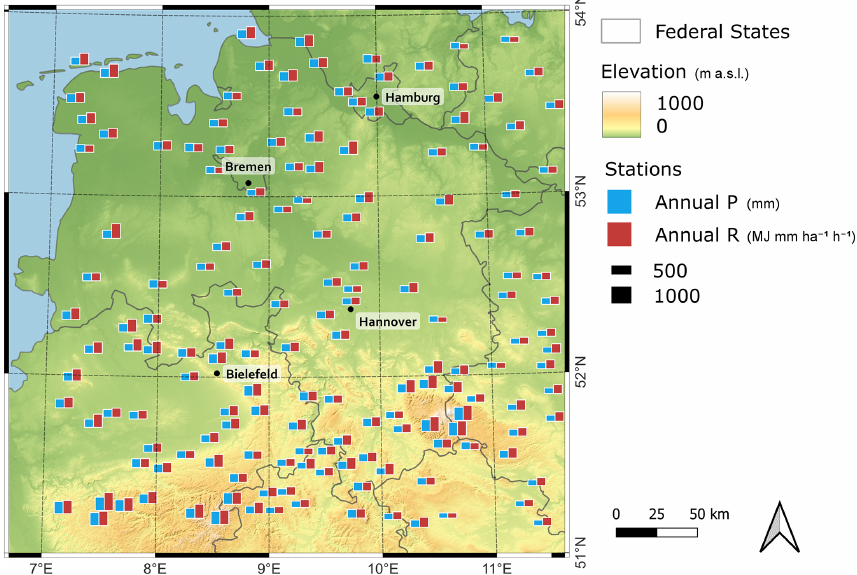
Figure 1. Location of all recording stations ( N = 159). The bar plots indicate the observed annual precipitation volume (blue) and erosivity factor (red).